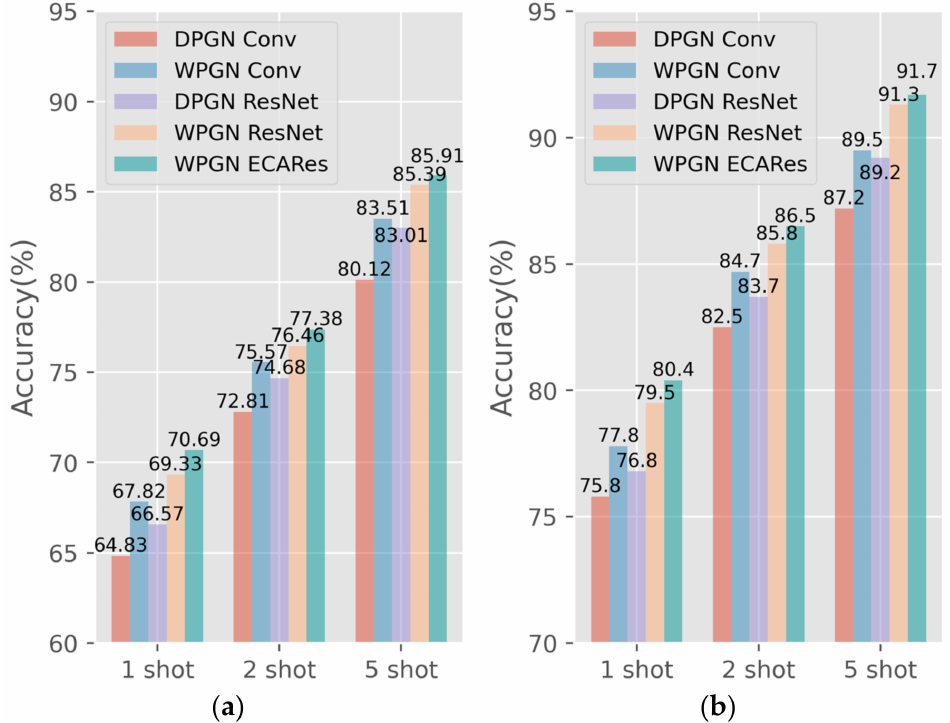
Figure 9. Experimental results on the MiniImagenet and CIFAR-FS. ( a ) MiniImagenet; ( b )